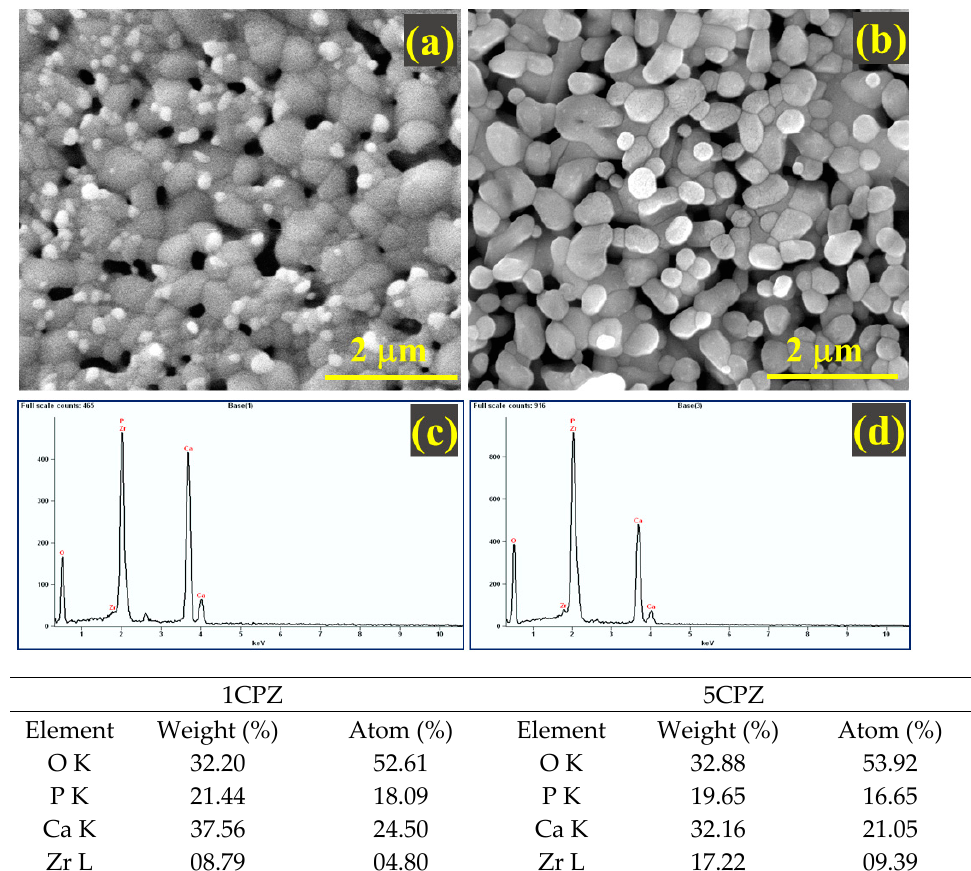
Figure 6. Microstructural features and energy-dispersive X-ray spectra of the β -Ca 3 (PO 4 ) 2 –ZrO 2 composites sintered at 1100 °C . ( a , b ) 1CPZ and 5CPZ micrographs, ( c , d ) corresponding EDS maps reveal the elemental composition: O, P, Ca, and Zr of 1CPZ and 5CPZ, respectively.